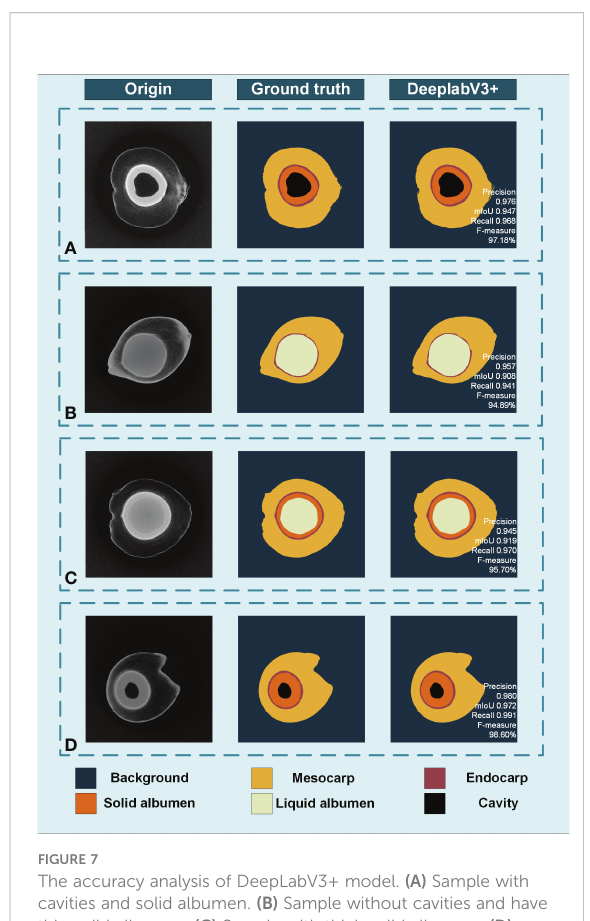
FIGURE 7 The accuracy analysis of DeepLabV3+ model. (A) Sample with cavities and solid albumen. (B) Sample without cavities and have thin solid albumen. (C) Sample with thick solid albumen. (D) Sample with thick solid albumen and cavities.